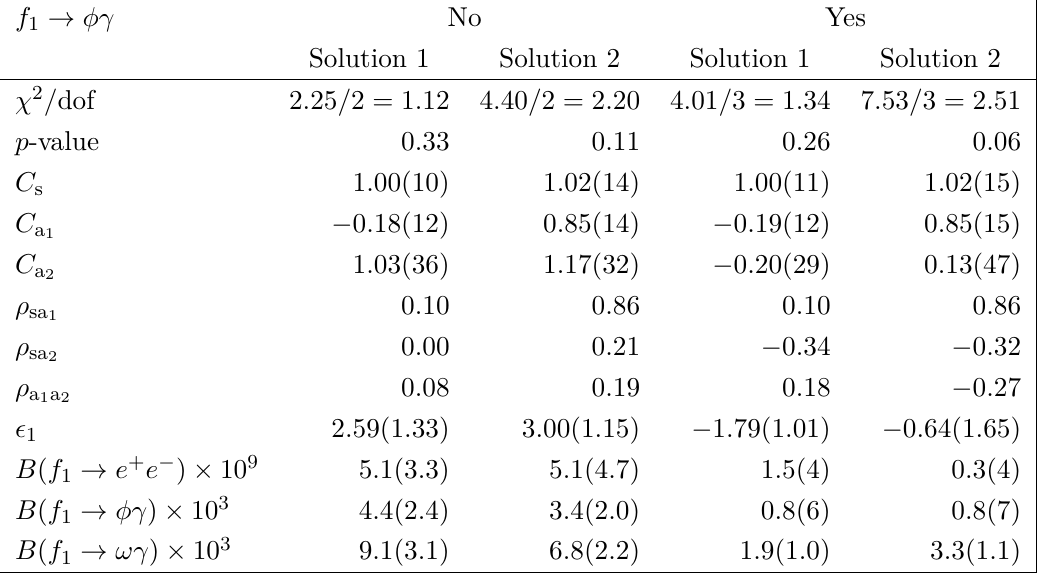
Table 9 . Same as table 8, but for the extended VMD case, including the resulting parameter (cid:15) 1 .